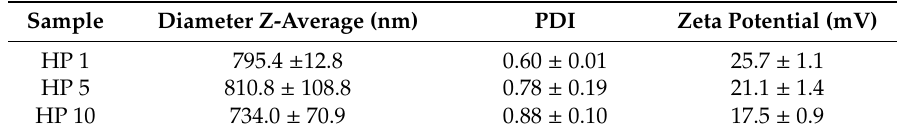
Table 2. Particle diameter, zeta potential, and polydispersity index (PDI) as a function of the CS:HP